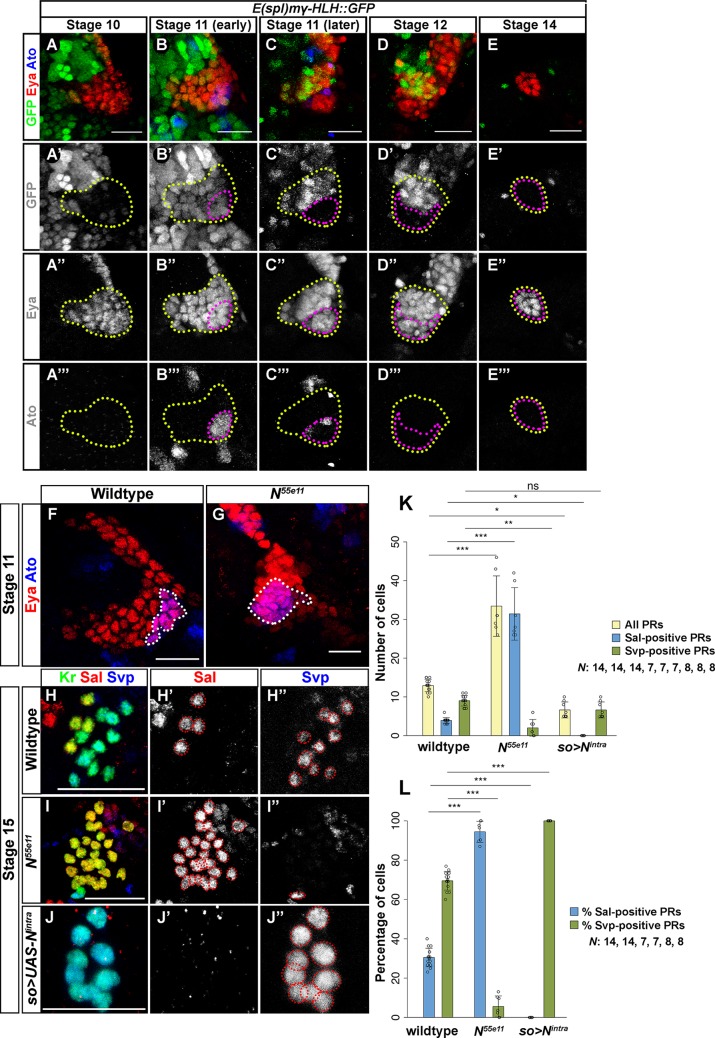
Notch regulates Ato-dependent PR cell fate in the embryo.(A-E) Notch activity in the optic placode at stages 10–14 determined by using the E(spl)mγ-HLH::GFP reporter line and staining embryos with anti-GFP (green), anti-Eya (red) and anti-Ato (blue) antibodies. Notch activity is dynamic: it is initially expressed in most cells in the placode early during stage 11 (outlined in yellow), and then it becomes excluded from the patch of Ato-expressing cells, which later will develop as PR precursors (outlined in purple). (F, G) Ato (blue, outlined in white) expression in the optic placode in wildtype and N55e11 mutant stage 11 embryos. The number of Ato expressing cells is significantly increased in N55e11 mutants (G). Sal (red) and Svp (blue) expression in the PR precursors at embryonic stage 15 in wildtype (H, H’, H”), N55e11 (I, I’, I”) and in the activated Notch overexpression (so>UAS-Nintra) (J, J’, J”). Kr (green) marks all PR precursors at this stage. Four Sal expressing primary PR precursors (H’) and 8–10 Svp expressing secondary PR precursors (H”) are seen in wildtype. In N55e11 mutants the number of Sal expressing PRs is increased (I’), whereas in Nintra overexpression embryos they are absent (J’). In N55e11 mutants Svp expressing PRs are significantly reduced or absent (I”) while Nintra overexpression does not affect the number of Svp expressing PRs (J”). (K, L) Quantification of PR number (K) and percentage of Sal- and Svp-positive PRs (L) in wildtype, N55e11 mutant and so>UAS-Nintra overexpression embryos. In N55e11 mutants a higher number of PR precursors is specified compared to wildtype control (counted at stage 14–16). N55e11 mutants possess more Sal-positive primary PR precursors than wildtype, whereas no Sal-positive cells were found in Nintra overexpressing embryos. Conversely, Svp-positive secondary PR precursors are severely reduced in N55e11 mutants whereas in Nintra overexpressing embryos they represent 100% of the PR precursors. Number of all PRs: wildtype vs N55e11 p<0.001, t = -8.203; wildtype vs so>NIntra p = 0.048, t = 2.634; Number of all Sal-positive cells: wildtype vs N55e11 p<0.001, t = -19.020; wildtype vs so>NIntra p = 0.0312, t = 2.838; Number of all Svp-positive cells: wildtype vs N55e11 p = 0.0028, t = 3.692; wildtype vs so>NIntra p = 0.6041, t = 1.308 (K). Ratio of Sal-positive cells: wildtype vs N55e11 p<0.001, t = -17.594; wildtype vs so>NIntra p<0.001, t = 8.764; Ratio of Svp-positive cells: wildtype vs N55e11 p<0.001, t = 12.425; wildtype vs so>NIntra p<0.001, t = -6.189 (L). n = 14 (wildtype), 7 (N55e11), 8 (so>NIntra) (K, L). Data is shown as mean and error bars as standard deviation. Circles represent numbers or percentages of individual samples. *** p<0.001, **p<0.01, *p<0.05 and ns = not significant (K, L). Scale bars represent 20 μm.